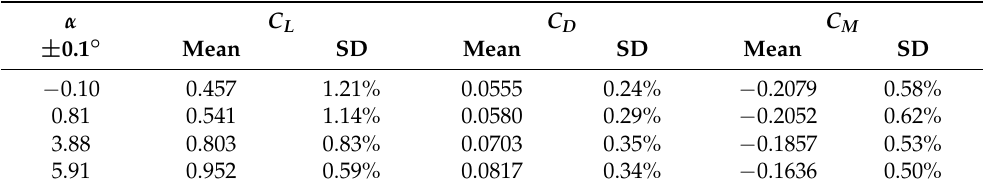
Table 2. Uncertainty in measurements of lift, drag, and pitching moment coefficients. WB configura-